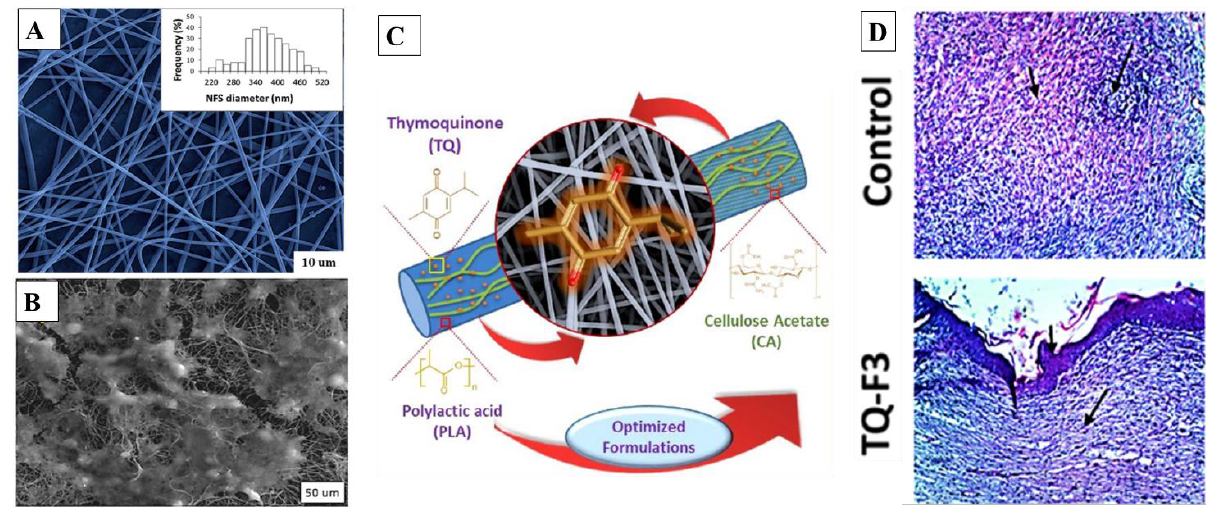
Figure 2. Overall representation of fabricating and testing of thymoquinone-loaded PLA/CA nanocomposite. ( A ) SEM micrograph of nanofibers, ( B ) SEM micrograph of cells on nanofibers, ( C ) overall design on the construct, and ( D ) histopathological results. Reprinted with permission from Reference [46] .